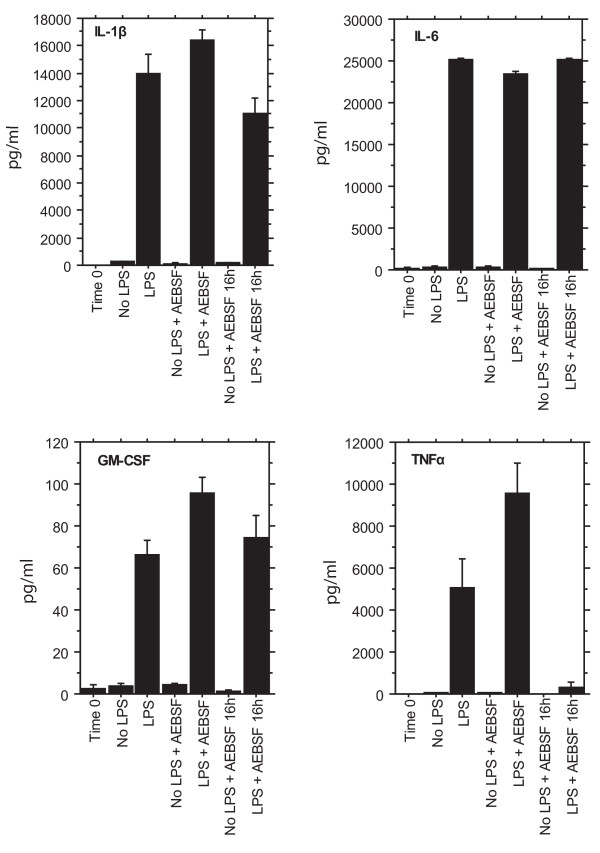
Effects of LPS and AEBSF on cytokine secretion by monocytes. Four of the ten cytokines assayed in culture medium from monocytes cultured for 16 h ± LPS ± AEBSF are shown. The first bar is Time 0, a control of monocyte medium taken at the start of culture. The last two bars show the effect of AEBSF added at the end of the culture at 16 h. Results are means ± SE, n = 4 donors. LPS was required for cytokine expression; AEBSF did not interfere, except that AEBSF added at the end of the experiment did reduce TNFα secretion. IL-8 and IL-10 responses were similar to IL-1β and IL-6 (not shown).